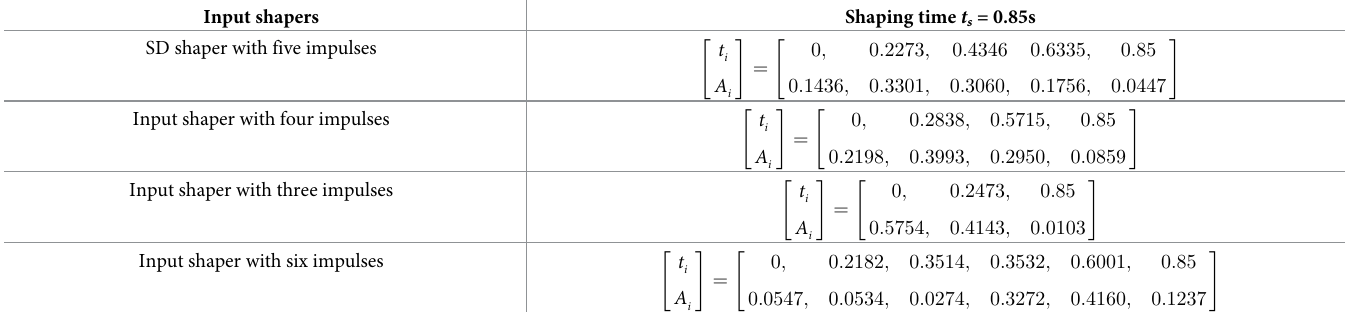
Table 1. The SD shaper with five impulses and input shapers with three, four and six impulses for the shaping time t s = 0.85s.